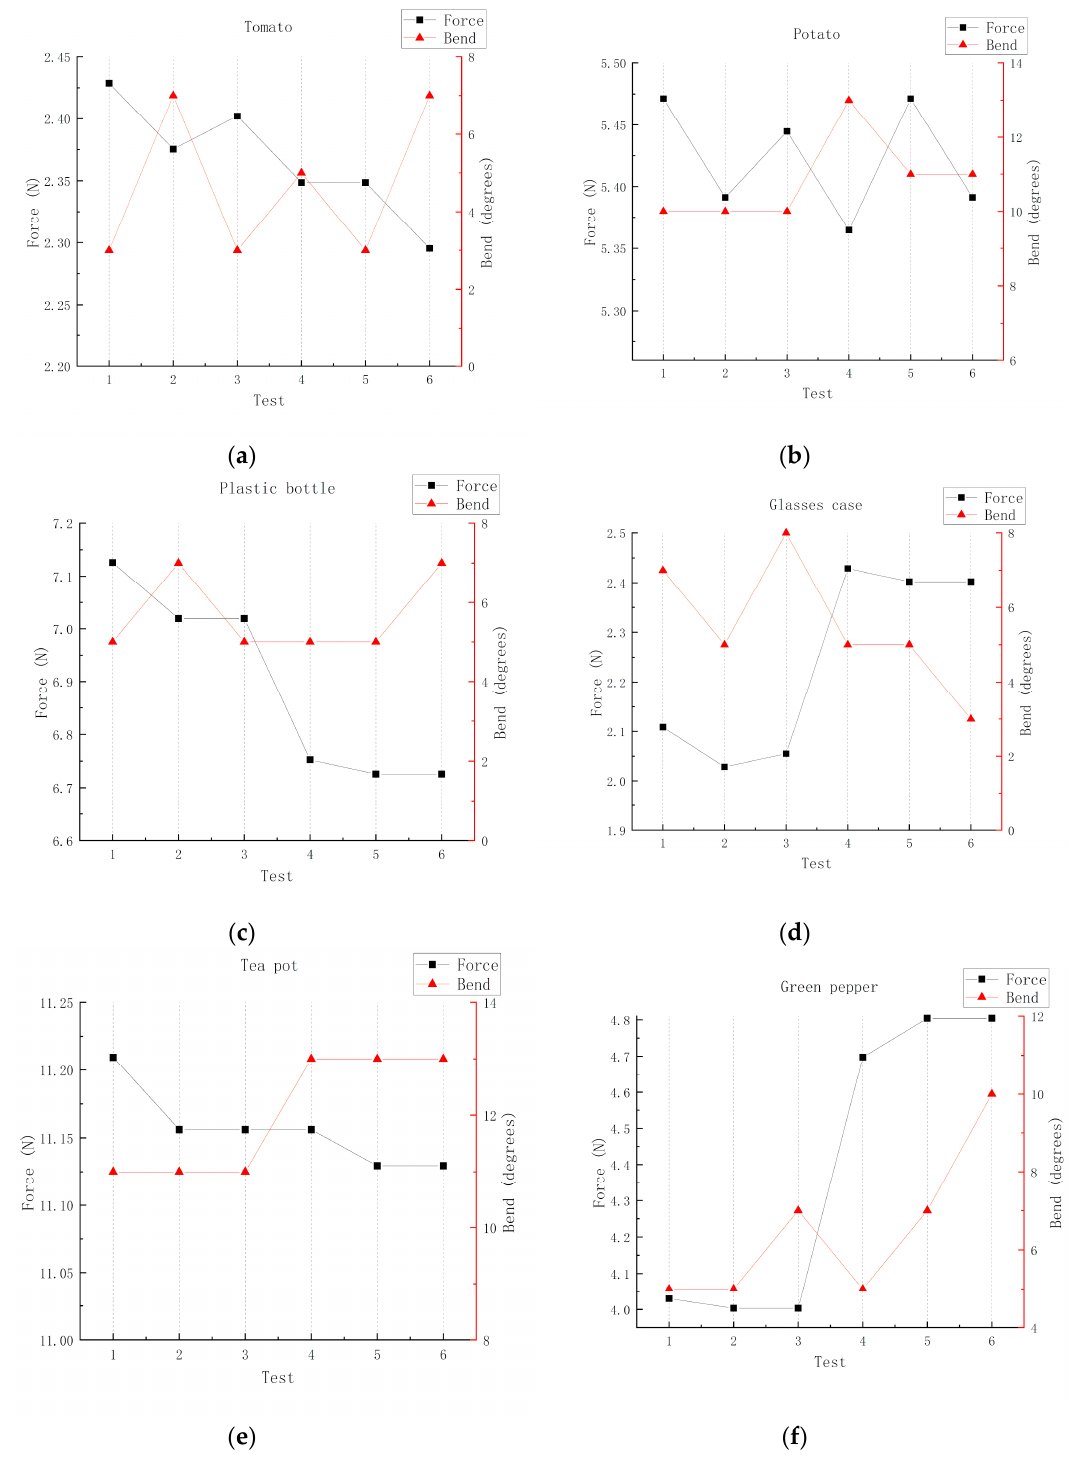
Figure 11. The relationship between force and bending angle under different conditions. ( a ) Grasp for tomato (bending angle and force). ( b ) Grasp for potato (bending angle and force). ( c ) Grasp for plastic bottle (bending angle and force). ( d ) Grasp for glasses case (bending angle and force). ( e ) Grasp for tea pot (bending angle and force). ( f ) Grasp for green pepper (bending angle and force).